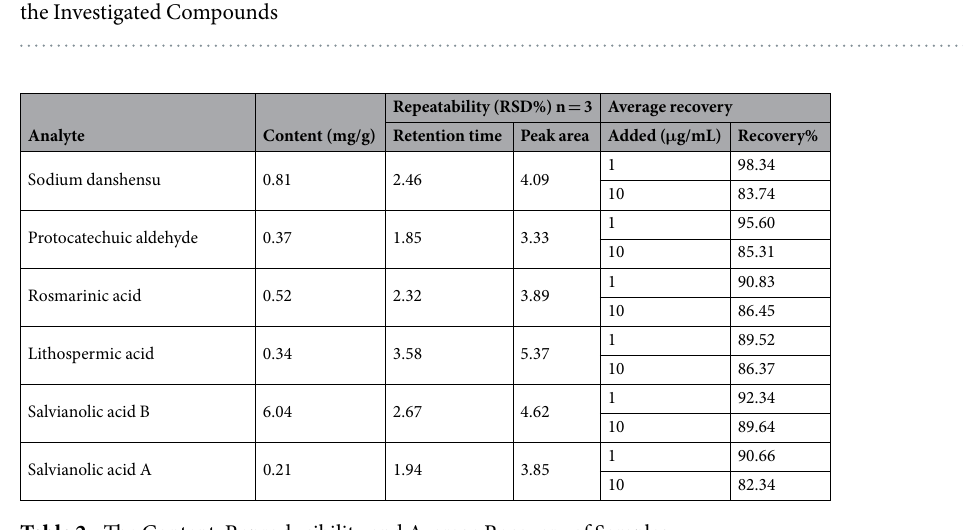
Table 2. The Content, Reproducibility and Average Recovery of